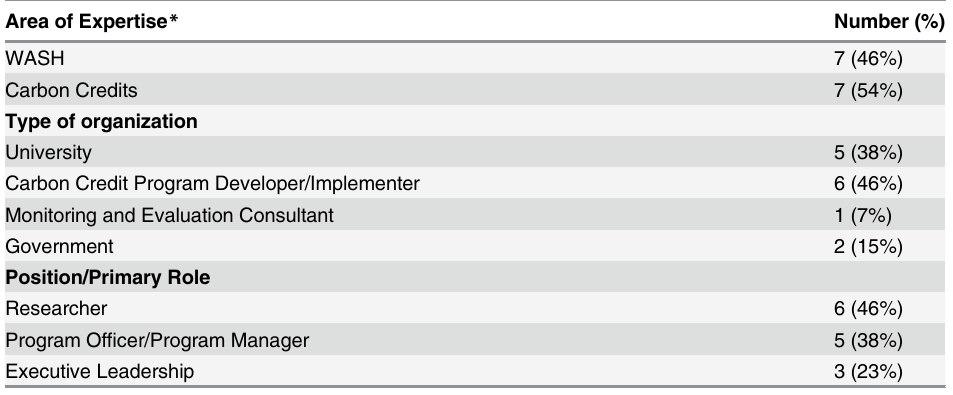
Table 2. Background information on study participants, by area of expertise, type of organization and position. Area of Expertise